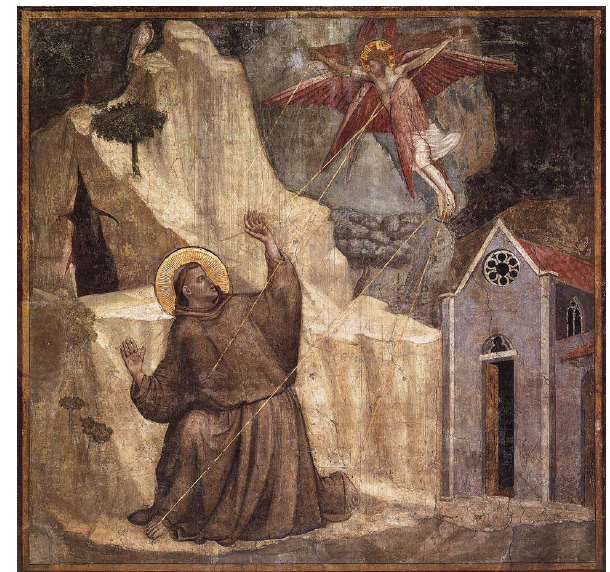
Figure 18. St. Francis receiving the stigmata by Giotto (1318).